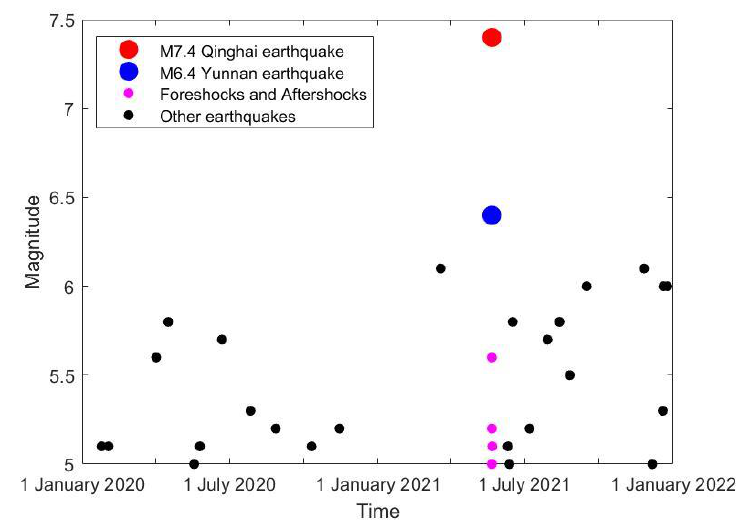
Figure 3. The time and magnitude of the earthquakes.